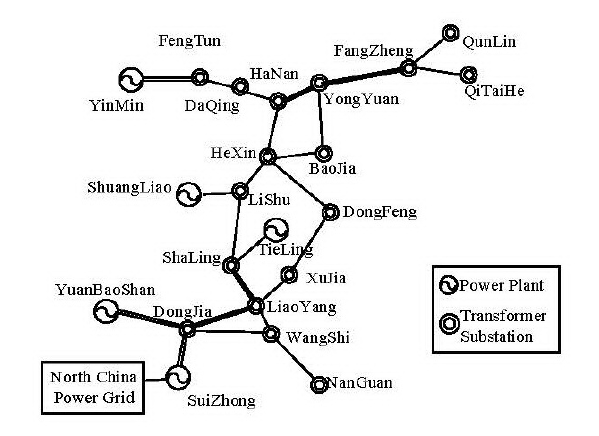
Figure 9. NCPG 500 kV Grid structure.